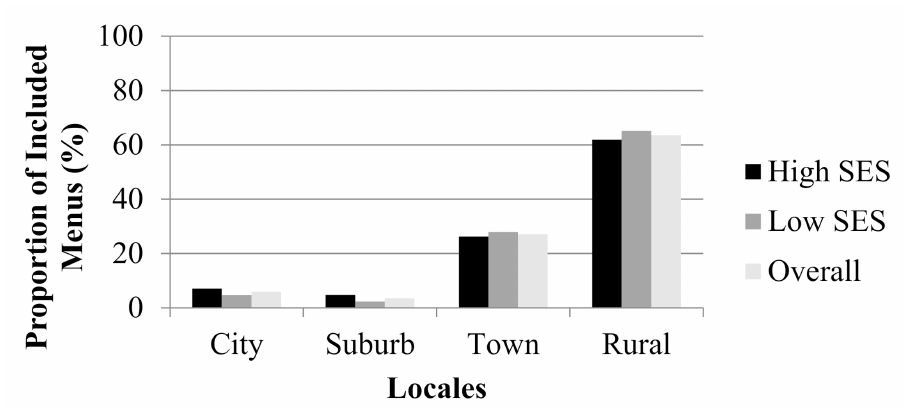
Figure 3. Proportion of included menus by locale. There were no significant di ff erences between strata or overall in proportion of menus by locale ( p >